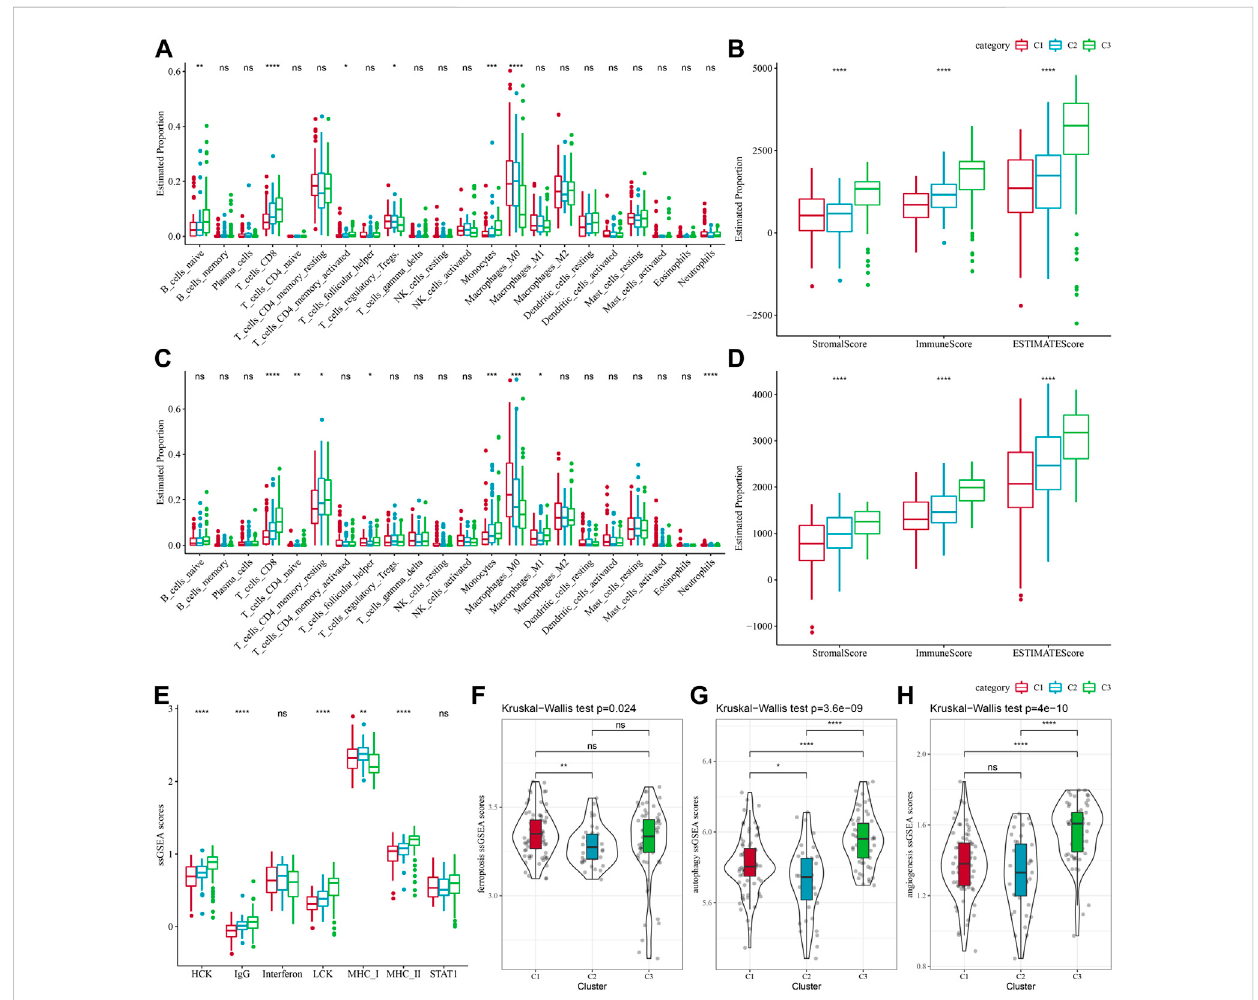
FIGURE 3 Immune characteristics of different subtypes. (A) TCGA-PAAD molecular subtypes varied in the differences of 22 immune cell scores; (B) TCGA- PAAD molecular subtypes varied in the differences of ESTIMATE immune in fi ltration; (C) PACA-AU molecular subtypes varied in the differences of 22 immune cell scores; (D) PACA-AU molecular subtypes varied in the differences of ESTIMATE in immune in fi ltration; (E) TCGA-PAAD molecular subtypes varied in the differences of scores of seven in fl ammation-related gene clusters; (F) TCGA-PAAD molecular subtypes varied in the differences of ferroptosis pathway; (G) TCGA-PAAD molecular subtypes varied in the differences in scores of autophagy pathway; (H) TCGA-PAAD molecular subtypes varied in the differences in scores of angiogenesis-related genes; * p < 0.05; ** p < 0.01; *** p < 0.001; and **** p <